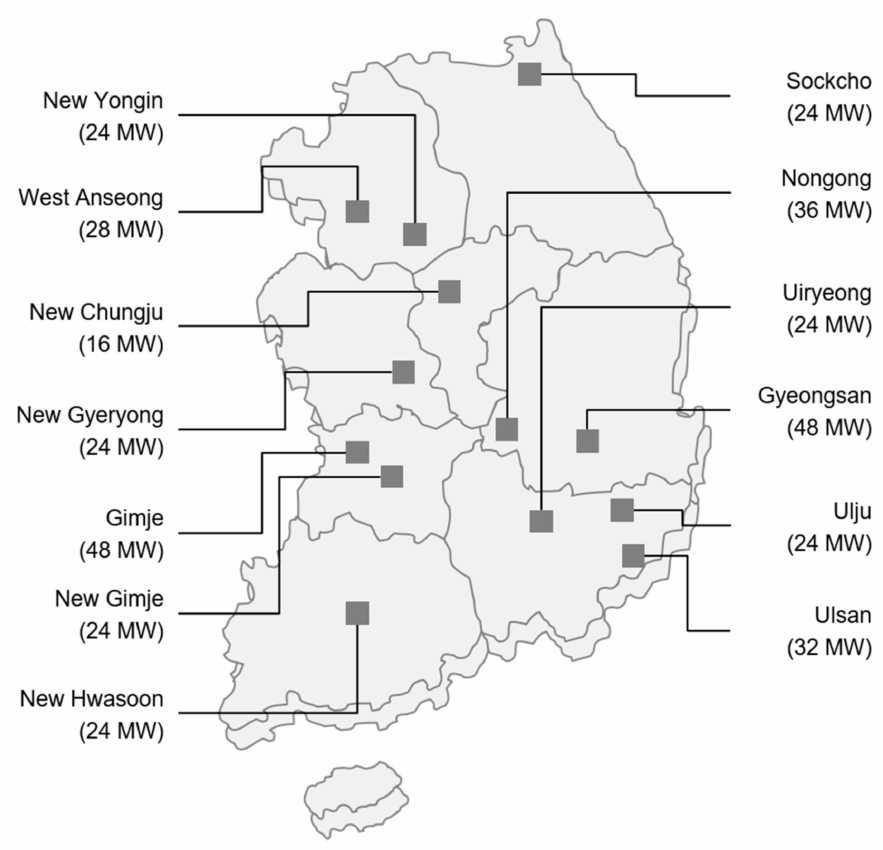
Figure 2. FR BESS locations in South Korea [8,22].